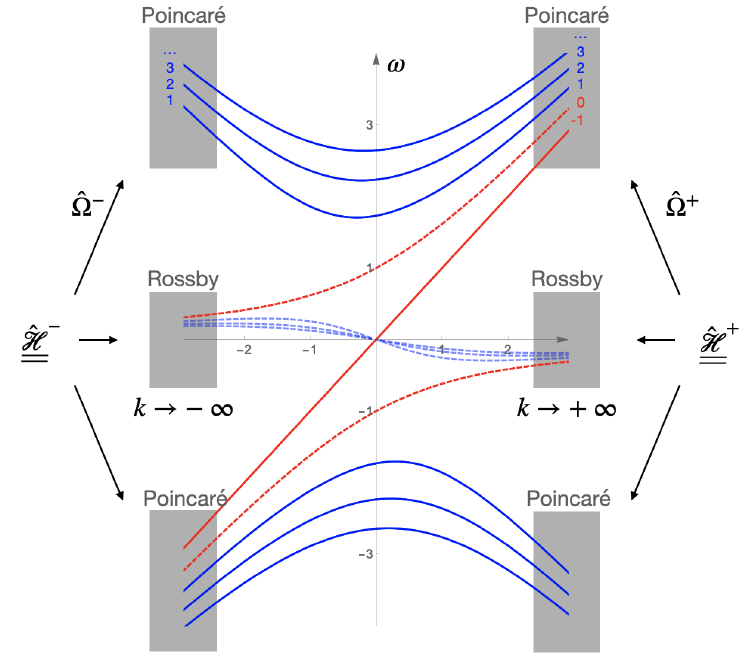
Figure 2: Eigenvalues of the beta plane shallow water wave operator defined in (3), as a function of the zonal wavenumber k , for β = 1, c = 1, often referred to as the Matsuno spectrum [ 1 ] . Two modes (in red) are gained by the positive-frequency Poincaré wave band as k increases. The aim of this paper is to interpret this spectral flow using semi-classical